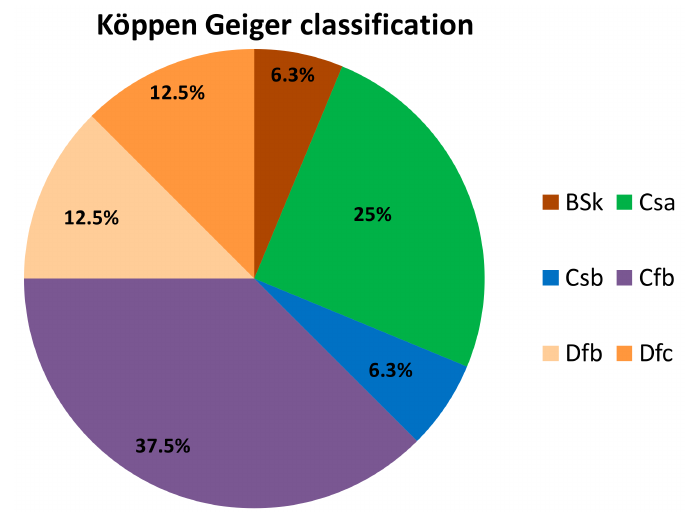
Figure 4. Distribution of the Köppen–Geiger climate classification obtained for the studied cases.